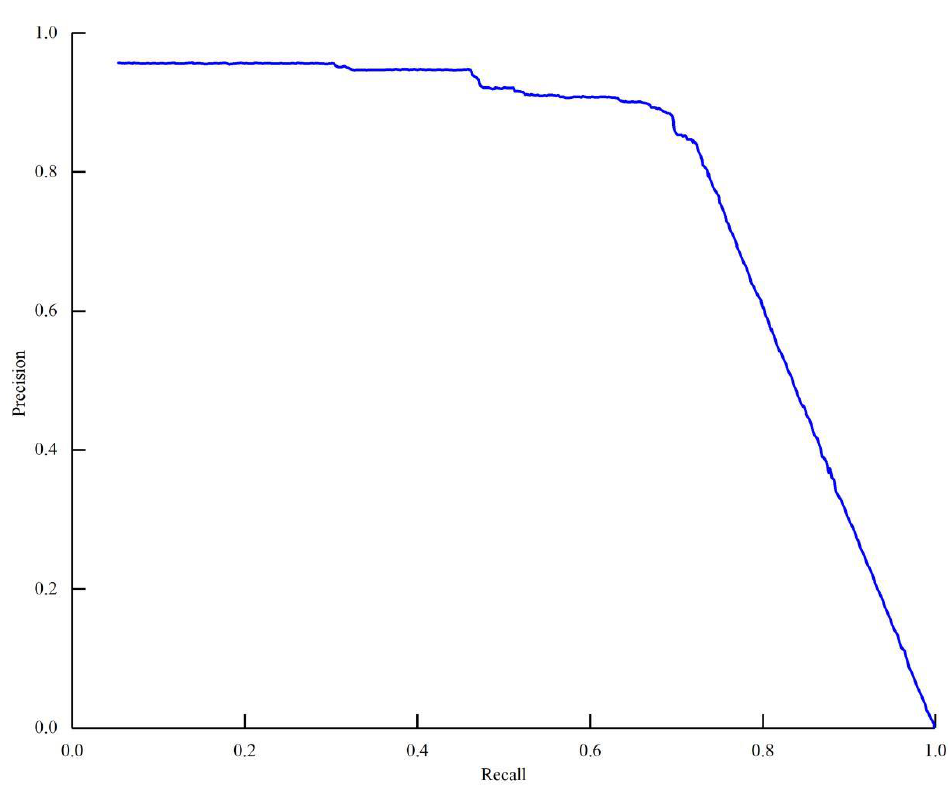
Figure 5. Precision – recall curve of